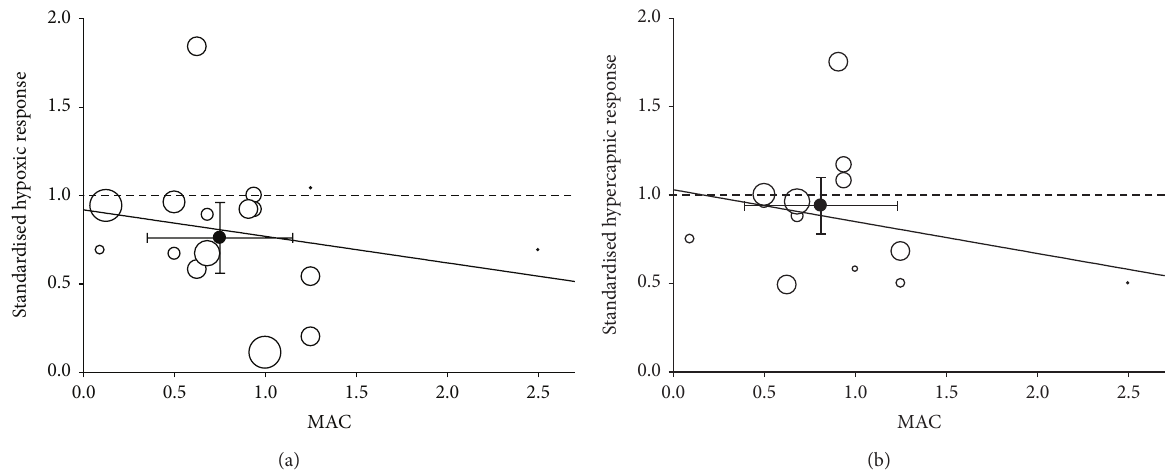
Figure 2: (a) Standardised anaesthetic effect on hypoxic response for each of the studies in Table 1. The horizontal dashed line indicates that at a value of < 1.0 for standardised anaesthetic effect implies depression of hypoxic response by agent; a value of 1.0 indicates no effect and a value > 1.0 suggests stimulation by agent. Each study is plotted by size (diameter) of the symbol (smallest 𝑛 = 1 ; largest 𝑛 = 10 ). The dark symbol represents the weighted mean value and error bars ± 95% confidence intervals. (b) Standardised anaesthetic effect on hypercapnic response for each of the studies in Table 1. Within each panel the solid line indicates the best fit line (linear weighted least squares regression). The best fit equation for hypoxia is 𝑦 = −0.1479𝑥 + 0.9194 ; that for hypercapnia is 𝑦 = −0.1762𝑥 + 1.03